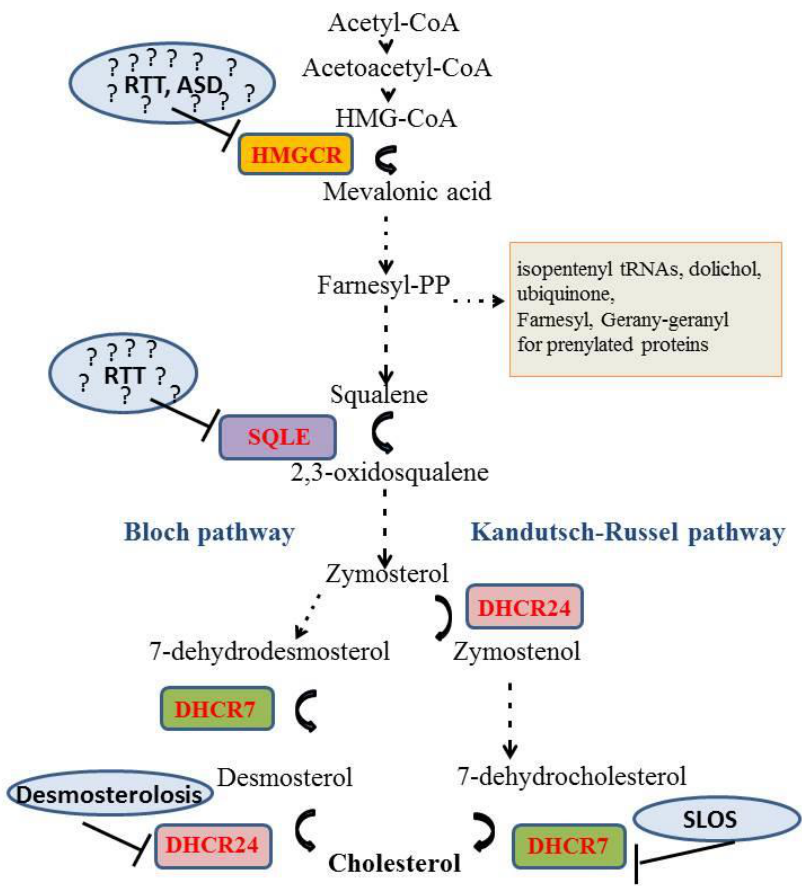
Figure 1. Schematic representation of MVA pathway. Enzymes involved or potentially involved in neurologic and psychiatric diseases are highlighted in blue circles. Autism spectrum disorder (ASD), 3-hydroxy-3-methylglutaryl Coenzyme A reductase (HMGCR); 7-dehydrocholesterol reductase (DHCR7); 24-dehydrocholesterol reductase (DHCR24), Rett syndrome (RTT); Squalene Epoxidase (SQLE); Smith–Lemli–Opitz syndrome (SLOS). Dotted arrows represent multiple enzymatic reactions. ? represents the hypothetic involvement of the indicated enzyme in the onset of the disease.